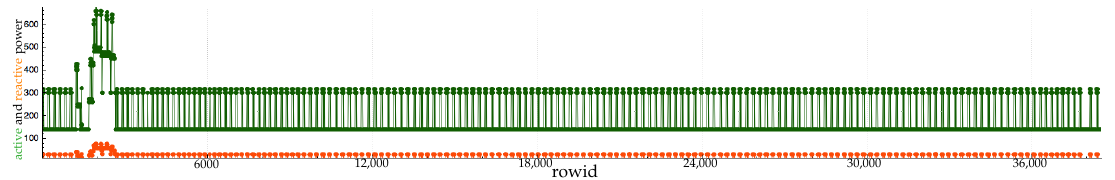
Figure 17. Evolution of electricity consumption in phase 1. Figure 20 details the variation around the spike.